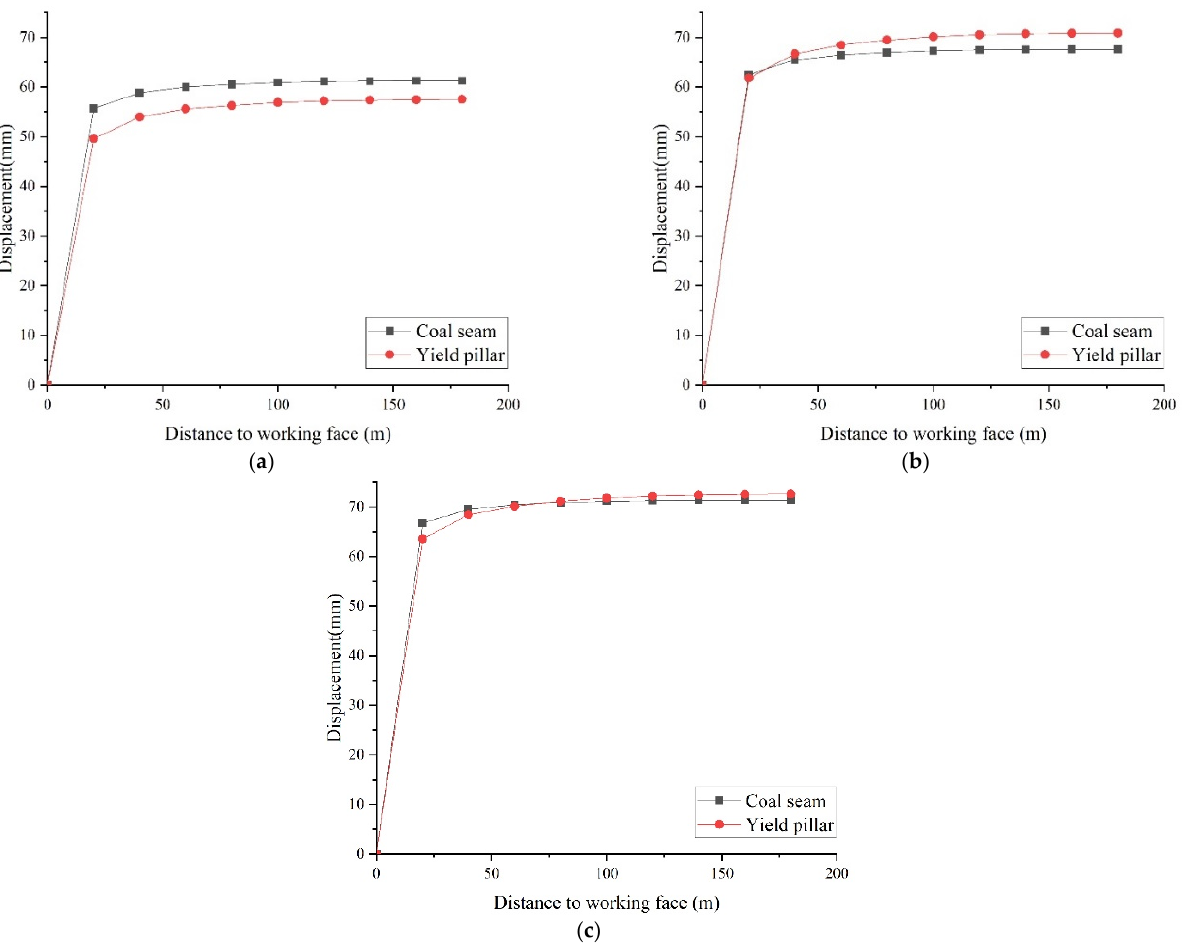
Figure 17. Two sides of roadways’ displacement with different yield pillar widths during driving: ( a ) model 4 m; ( b ) model 6 m; ( c ) model 8 m. Table 6. Evolution of yield pillar displacement during roadway driving with different yield pillar widths. Displacement and Displacement Ratio of the Yield Pillar When the Cumulative Displacement Distance of the Lagging Excavating Working Surface Is L e Pillar Width (m) of Yield Pillar L e = 20 m L e = 60